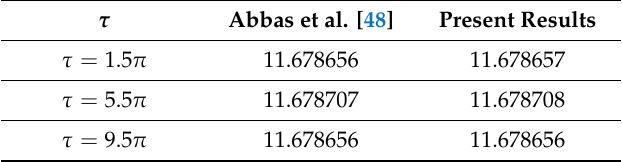
Table 1. Comparison of f ηη ( 0, τ ) with [48] when S = 1, Γ → ∞ , Ω = 0, δ = 0, λ = 0, Nr = 0 and Rb =